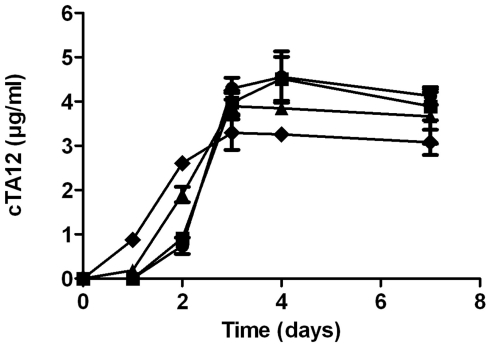
Production of cTA12 in Sf9 cells by infection of a recombinant baculovirus at different multiplicities of infection (MOI).1.35×107 cells seeded in T75 flasks were infected at different MOI (•: 0.04; ▪: 0.12; ▴0.4; ⧫1.2) with the recombinant baculovirus stock. cTA12 containing supernatants were harvested at different times and antibody was quantified by enzyme immunoassay.